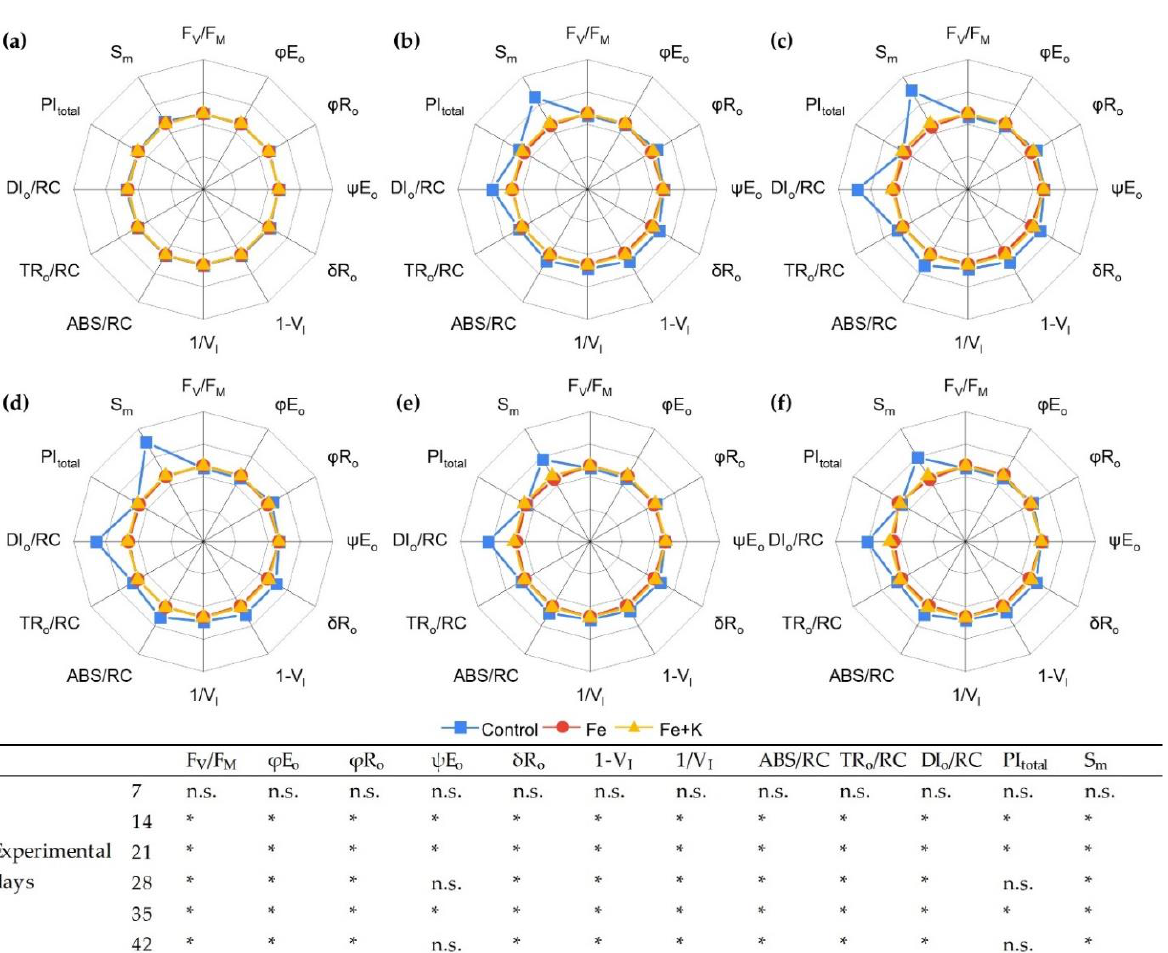
Figure 5. Spider plots of JIP parameters deduced from chl a fluorescence OJIP transient curves in lettuce (mean values, n = 48) for 6 experimental days. ( a ) Day 7; ( b ) Day 14; ( c ) Day 21; ( d ) Day 28; ( e ) Day 35; ( f ) Day 42. Values are normalized to the values of Fe+K treatment. The statistical results for each parameter and day are presented in the bottom table. Since there were no significant differences between Fe and Fe+K groups, all the sings refer to differences of control plants with the other two groups (n.s. means non-significant differences and the asterisk indicates differences at p < 0.001).